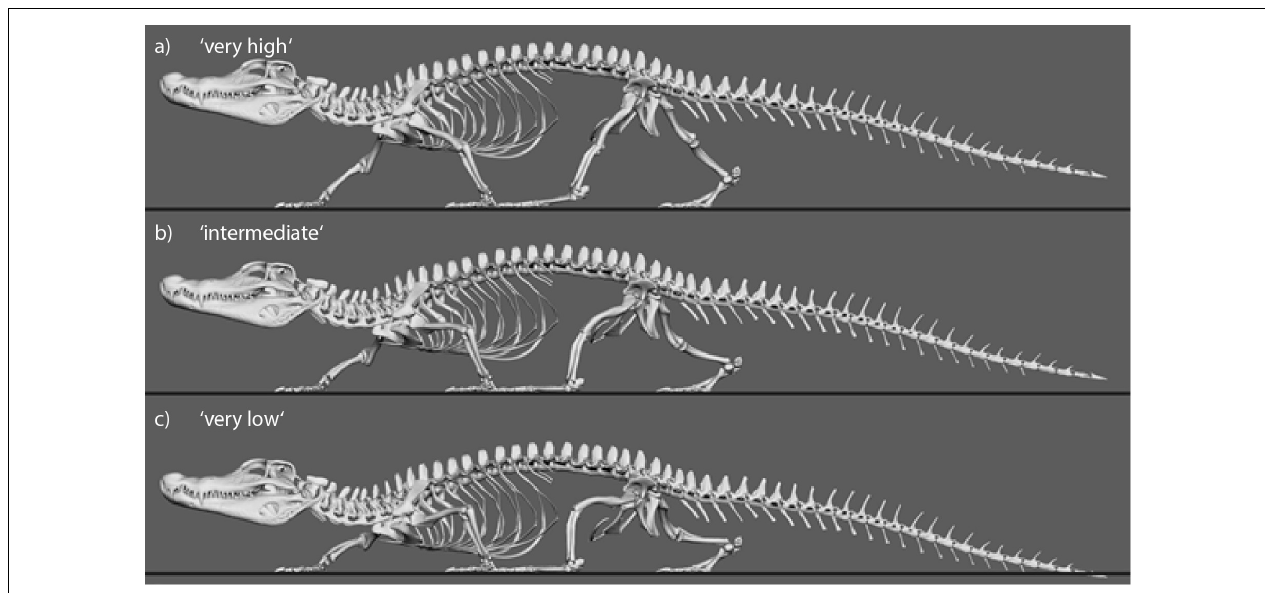
FIGURE 4 | Still images from animated Caiman locomotor cycle to illustrate the experimental variation of body height. Three of five variations are shown. (a) “Very high” with IGD = 0.69. (b) “Intermediate” with IGD = 0.49. (c) “Very low” with IGD = 0.29.